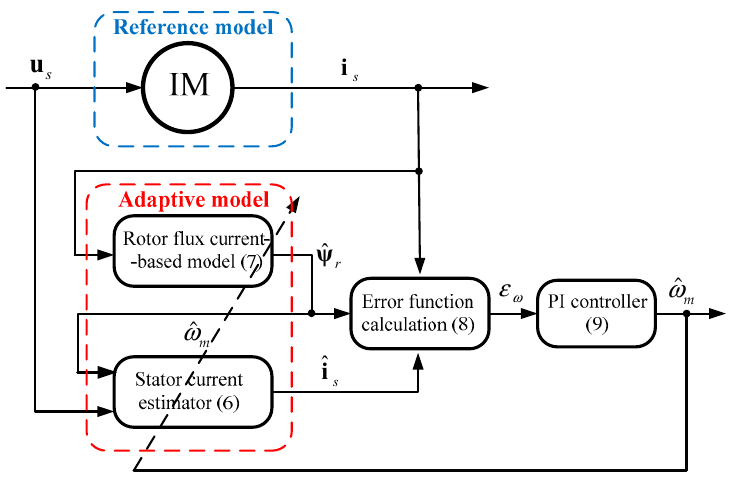
Figure 1. Schematic diagram of the classical MRAS CC estimator [35].